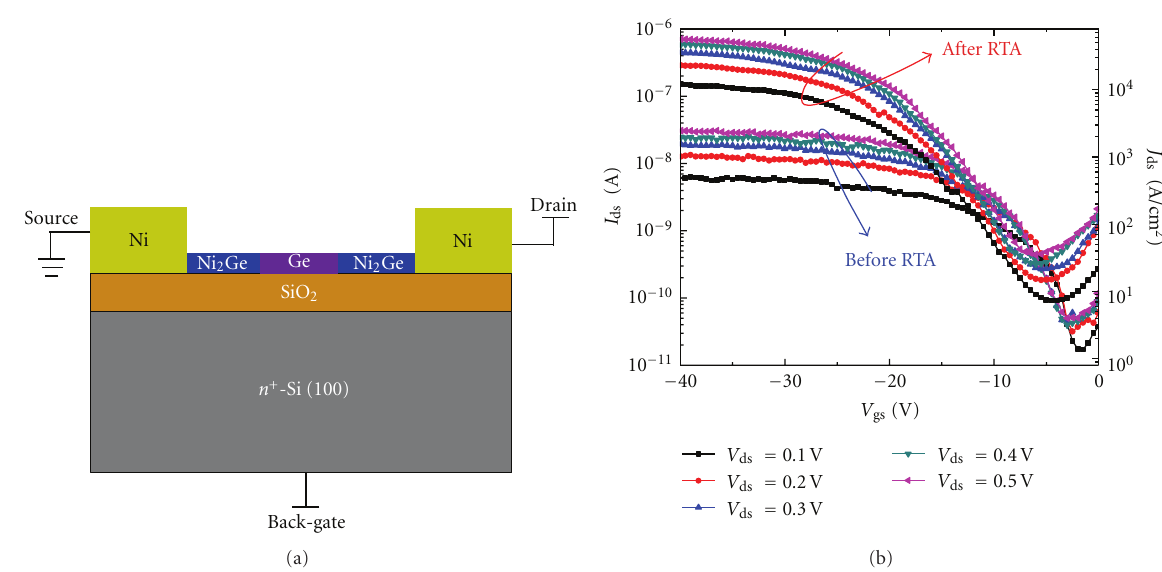
Figure 9: Electrical characterization of Ge nanowire back-gate FETs (without Al 2 O 3 capping during annealing) at 300 K. (a) Schematic illustration of a Ge nanowire back-gate FET. (b) I ds - V gs curves of the back-gate Ge nanowire transistor before and after RTA, both showing a p-type MOSFET behavior. The transistor performance was significantly improved after RTA, in which the Ni 2 Ge source/drain contacts were formed. Reproduced from